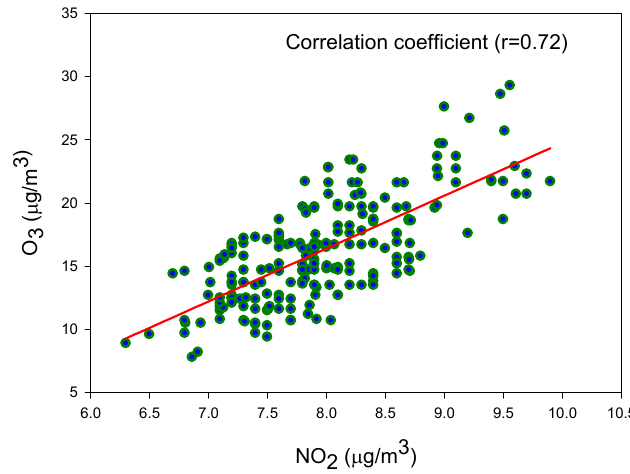
Figure 7. Correlation between O 3 and NO 2 during the night time in Vishu.